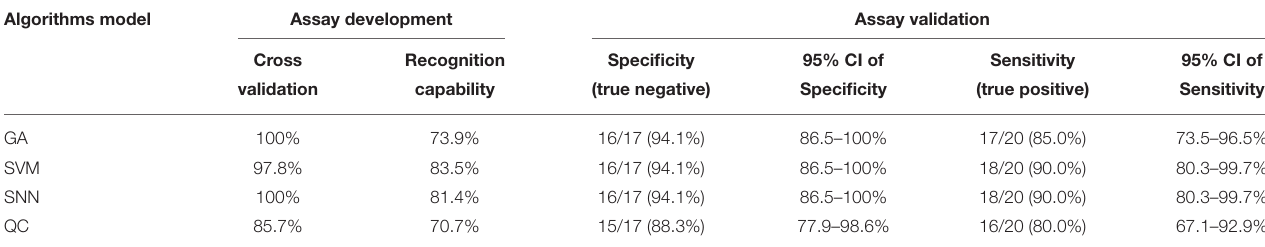
TABLE 3 | Specificity and sensitivity of different algorithms models for differentiation between K1 and non-K1 K. pneumoniae isolates. Algorithms model